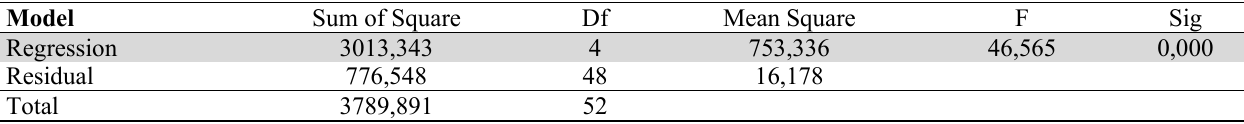
Test Results ANOVA